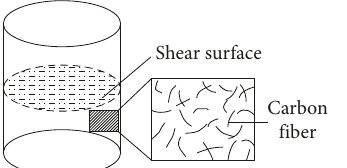
Figure 10: Schematic representation of carbon fiber distribution in the composite specimen.